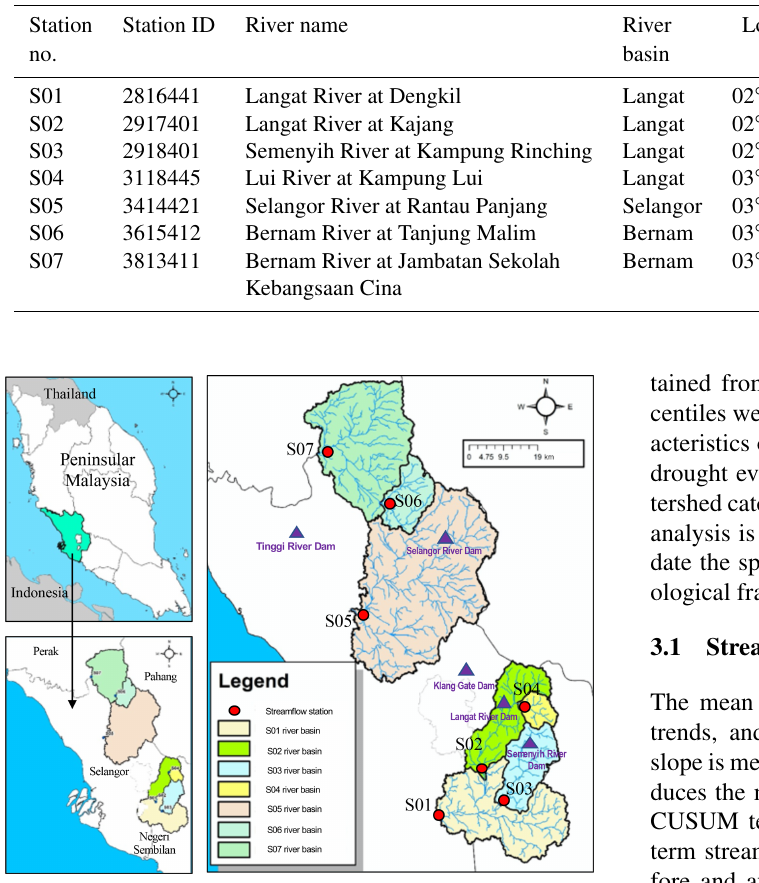
Figure 1. River basin and streamflow station in